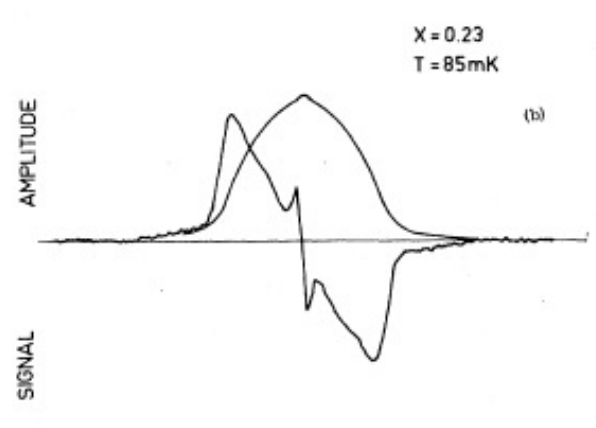
Figure 7. Observed NMR line shape for the quadrupolar glass state of solid H 2 for ortho-H 2 concentration x = 0.23 at a temperature of 85 mK. The experiments measured the derivative line shape using traditional lock-in methods, and the symmetrical dome shaped line is obtained by integration. Interestingly, a very small narrow peak is observed at the center that is the contribution from molecules with zero order parameter. Reproduced with permission from [21]. Copyright American Physical Society, 1978.